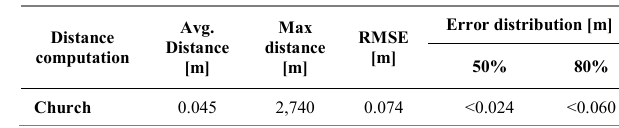
Table 4. Statistical results from the distance comparison between smartphone point clouds and the reference point